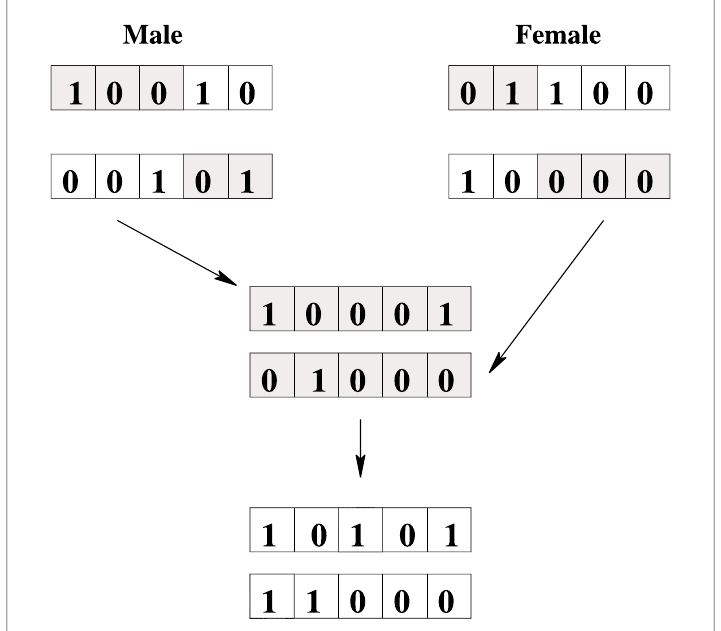
Fig. 2b – Schematic representation of the genomic changes for SX. (The di- agram for SX is also valid for HA, except that for HA all individuals can